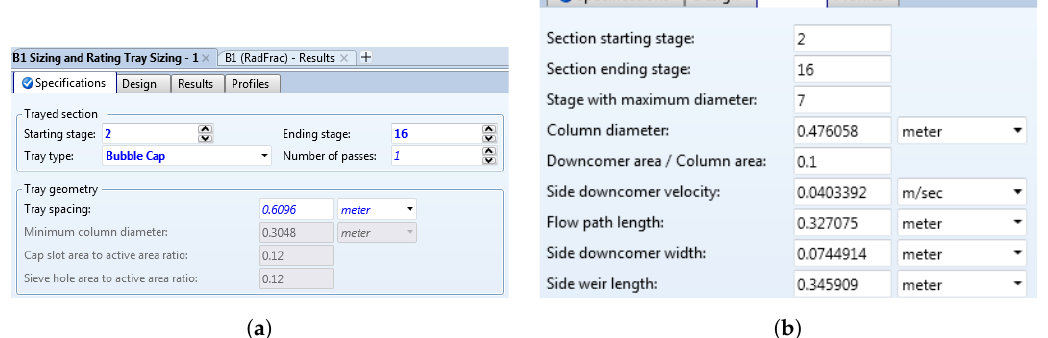
Figure 5. Aspen Plus ® screenshots for the sizing of the column. ( a ) Tray Sizing Input. ( b ) Tray Sizing Results.